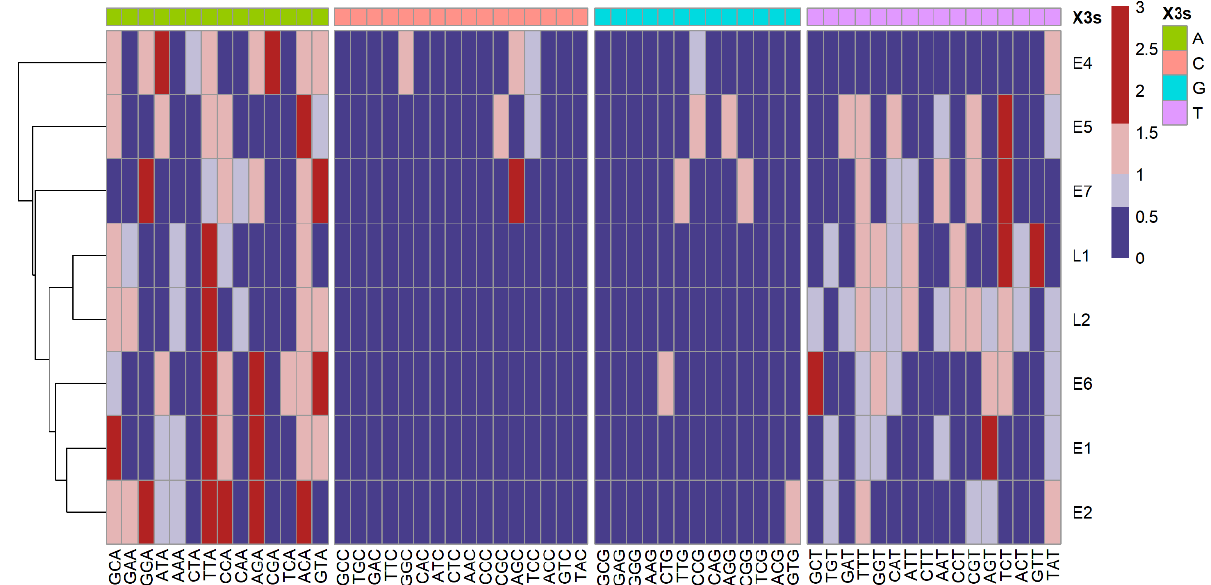
Figure 5. Relative synonymous codon usage (RSCU) analysis revealed over-representation of codons ending in A/T in HPV16 ORFs. Columns correspond to the 59 codons (three stop codons and those for Trp, Met were excluded). Rows correspond to the eight ORFs. Blue cells indicate under-represented codons (RSCU < 0.6) and red cells indicate over-represented codons (RSCU > 1.6). “X3s” indicates the nucleotide at the 3rd codon position.